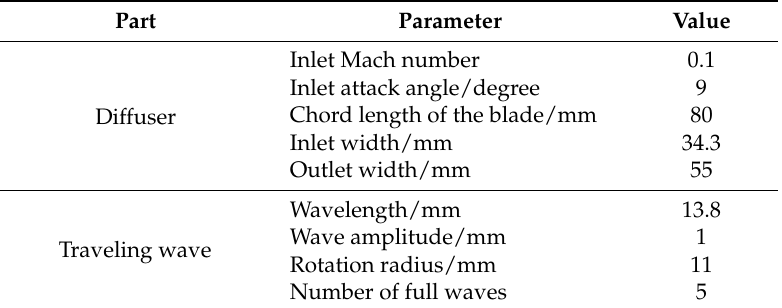
Figure 1. Adopted diffuser, mesh for numerical simulation and rigid traveling wave wall control: ( a ) geometry of the diffuser and rigid traveling wave wall; ( b ) the mesh for numerical simulation; ( c ) the geometry of the traveling wave wall. Table 1. Main parameters of the adopted diffuser and traveling wave wall.